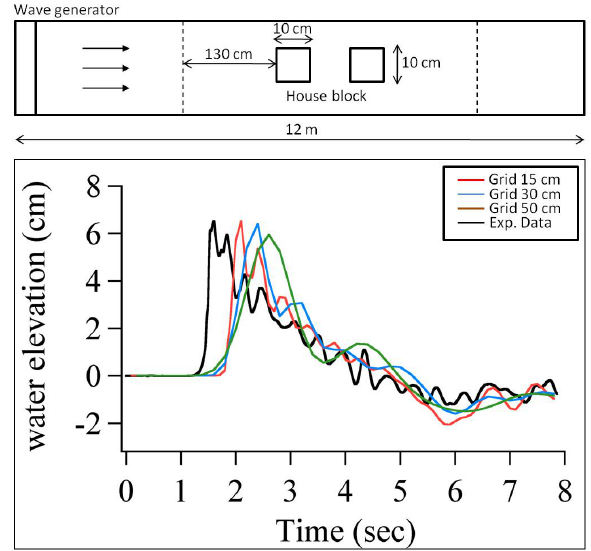
Fig. 7. Open channel experiment scheme (upper figure) conducted by Aburaya and Imamura (2002), and the resulting comparison with the ERM model (bottom figure) in front of the first obstacle.